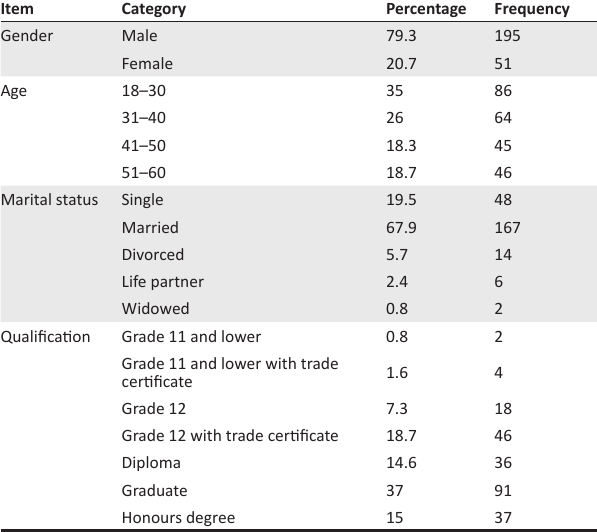
TABLE 1: Characteristics of participants in the